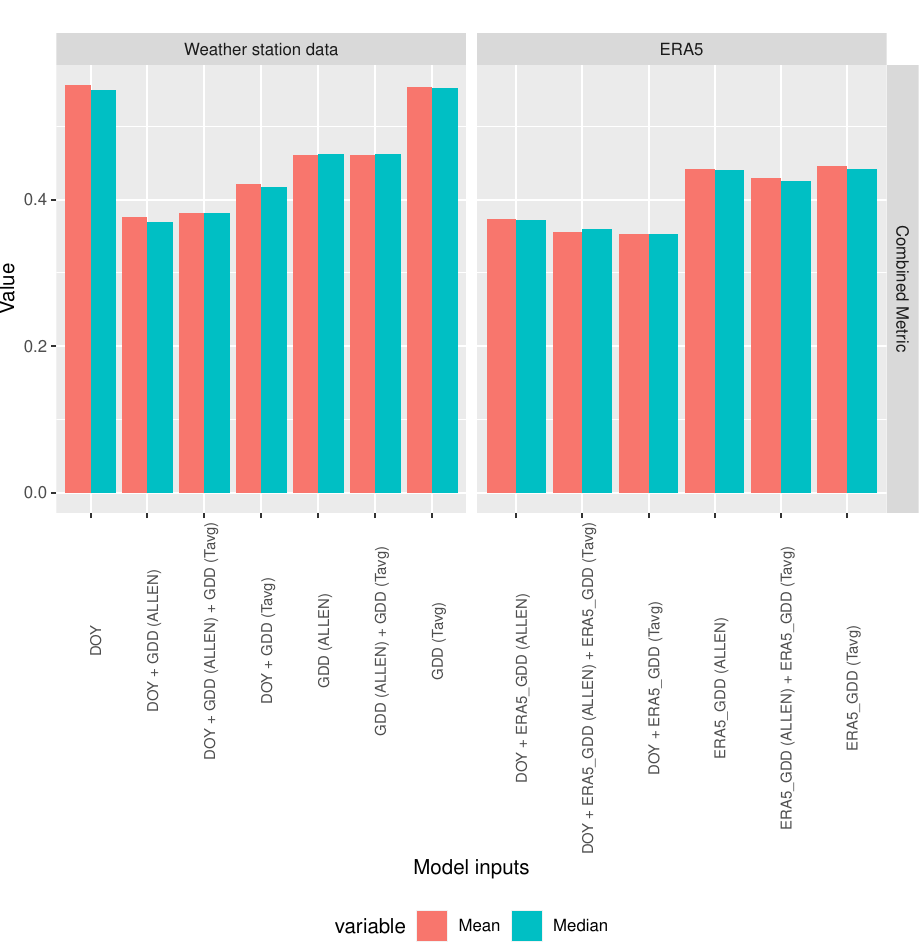
Figure 5. Combined metric mean and median values for random forest model performance comparison using different predictors.